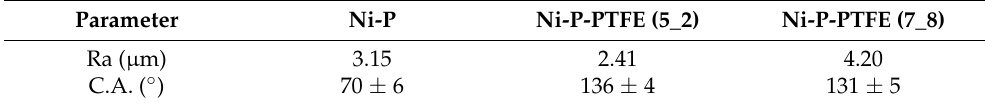
Table 3. Centre line average roughness (R a ) and contact angle of Ni-P and Ni-P-PTFE films. Parameter